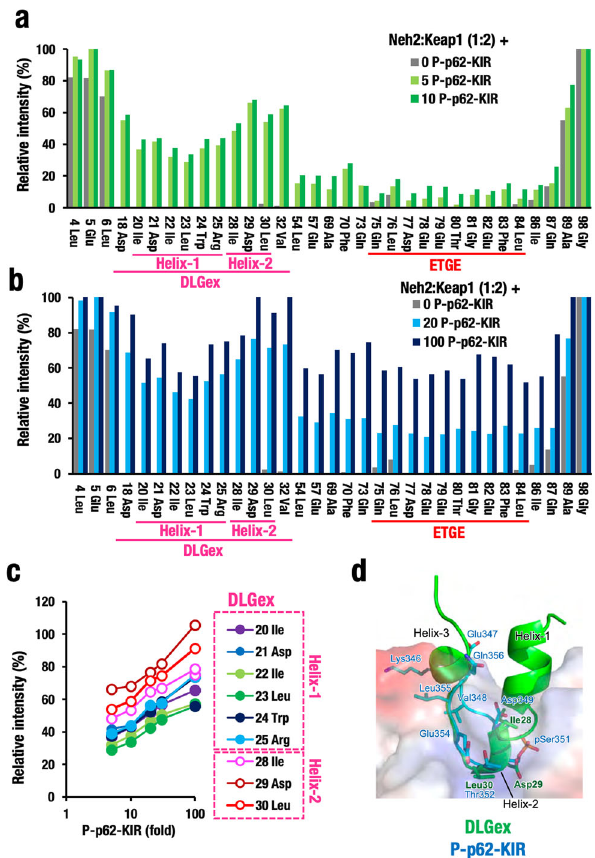
Fig. 6 Phosphorylated p62-KIR peptide preferentially inhibits Keap1 – DLGex interaction. a Relative peak intensity of each amino-acid residue of Neh2 in the Neh2 – Keap1 complex in the titration experiments by the addition of fi ve- and tenfold excess of phosphorylated p62-KIR (P-p62- KIR) peptide. Relative peak intensity of the NMR signal of each residue is calculated setting Neh2 only as 100%. b Relative peak intensity of each amino-acid residue of Neh2 in the Neh2 – Keap1 complex by the addition of 20- and 100-fold of P-p62-KIR peptide. c Relative peak intensity of the amino-acid residues within the DLGex motif after the addition of P-p62-KIR peptide. Closed and open circles indicate the amino-acid residues corresponding to Helix-1 and Helix-2, respectively. d Merged structural images of the Keap1-DC with the DLGex and P-p62-KIR. Note that binding of P-p62-KIR heavily overlaps with that of DLGex Helix-2 d and the P-p62- KIR titrates the binding of Helix-2 more ef fi ciently than that of Helix-1 ( a , b